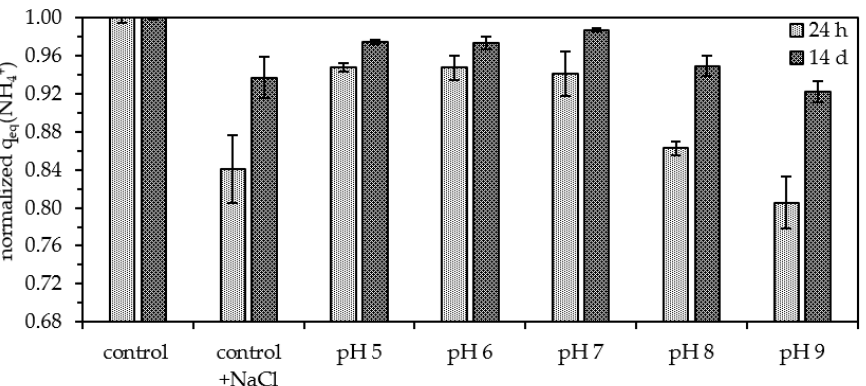
Figure 3. Influence of pH on the normalized q eq (NH 4+ ) after 24 h and 14 d (matrix: ultrapure water; t eq : 14 d; pH control = 5.9; pH control+NaCl : 6.2; c 0 (NH 4+ ) = 10 mgN/L; w / v = 100 g Z /L; T = 22 °C; grain size: 8–16 mm; n = 3).